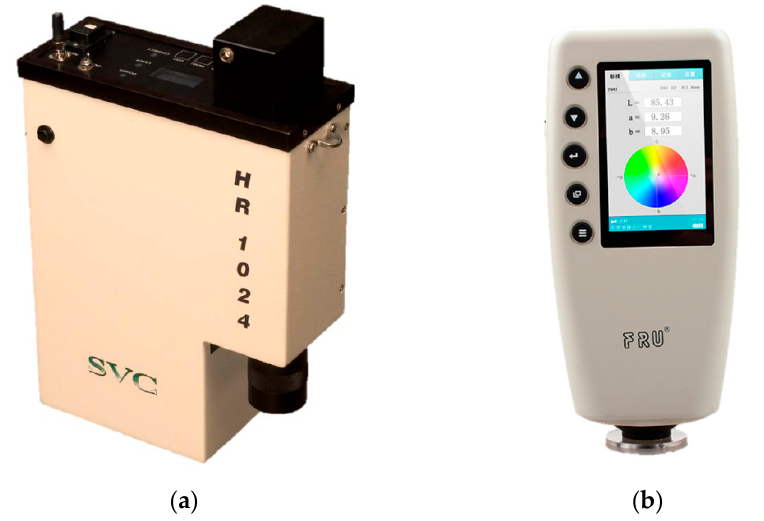
Figure 3. Spectroradiometer HR 1024 ( a ) [27] and Colorimeter WR-18 ( b ) [28].